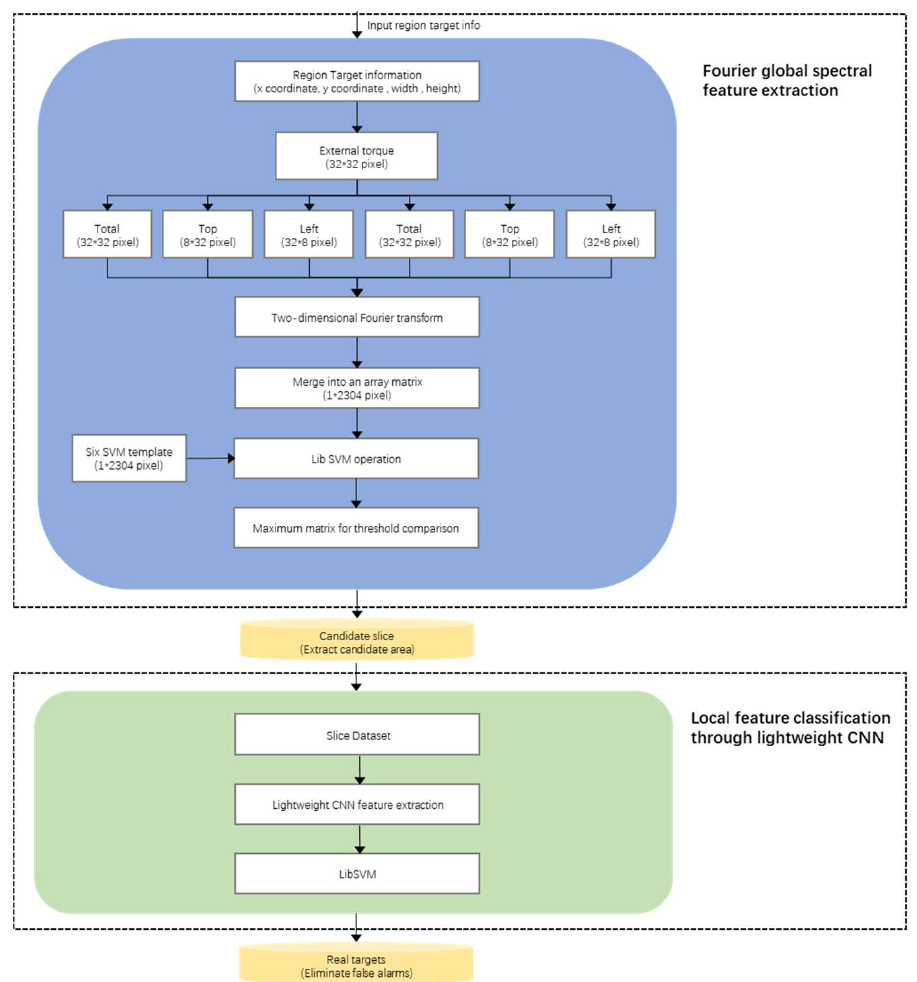
Figure 4. Schematic of the multiple-feature fusion classification process.